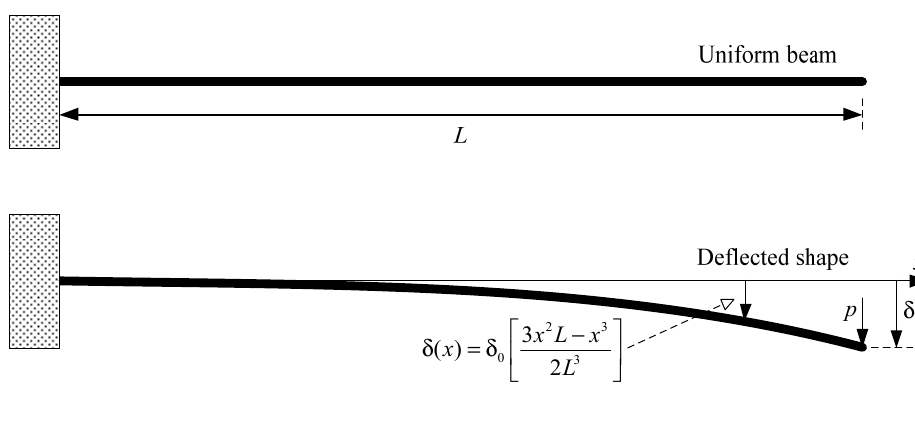
Figure 12. Simplified analysis of vibrations for a SDOF deflected